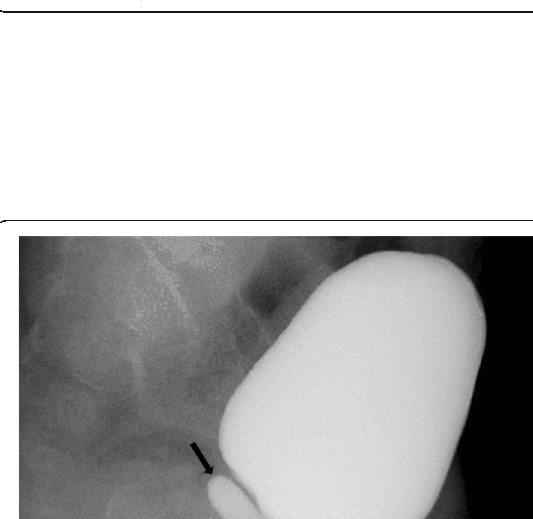
infection underwent a US exam and a midline cystic lesion was seen posterior of the bladder (not shown). Confirmatory MRI exam shows a tear-drop shaped midline cystic lesion (arrows) on the sagittal plane T2W image. The cystic lesion was extending above the posterior superior margin of the prostate, highly suggestive for the